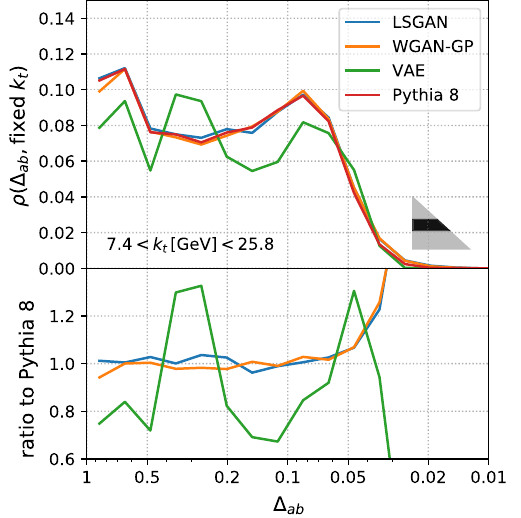
Fig. 9 Slice of the Lund plane along k t with 0 . 13 < Δ ab < 0 .